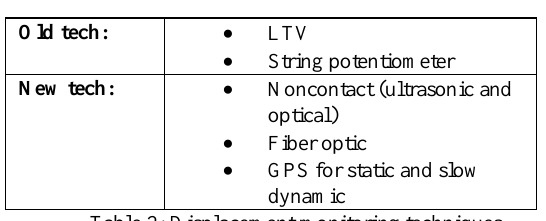
Table 2: Displacement monitoring techniques (Live et al.,